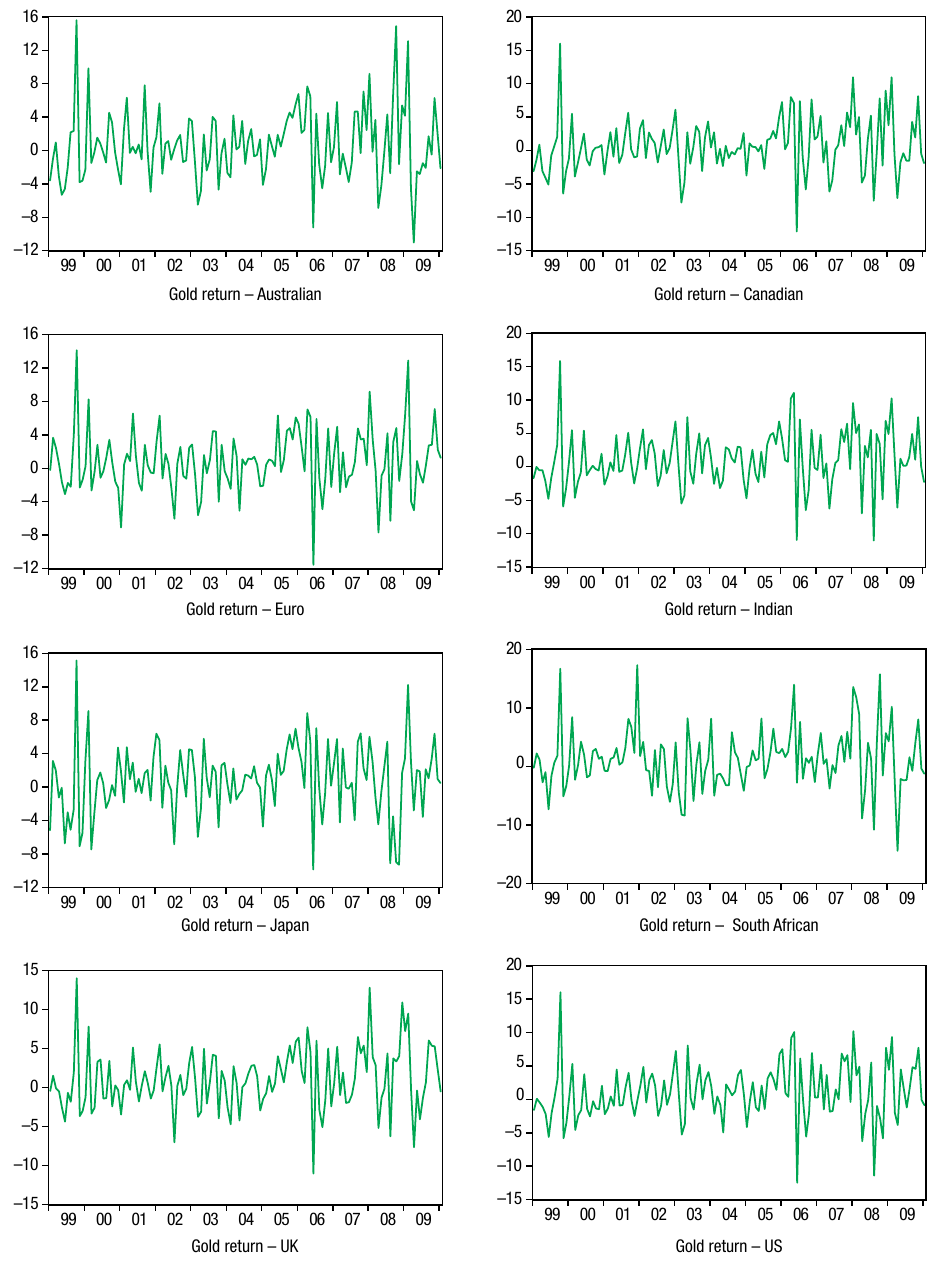
Fig. 5. The trends of the gold